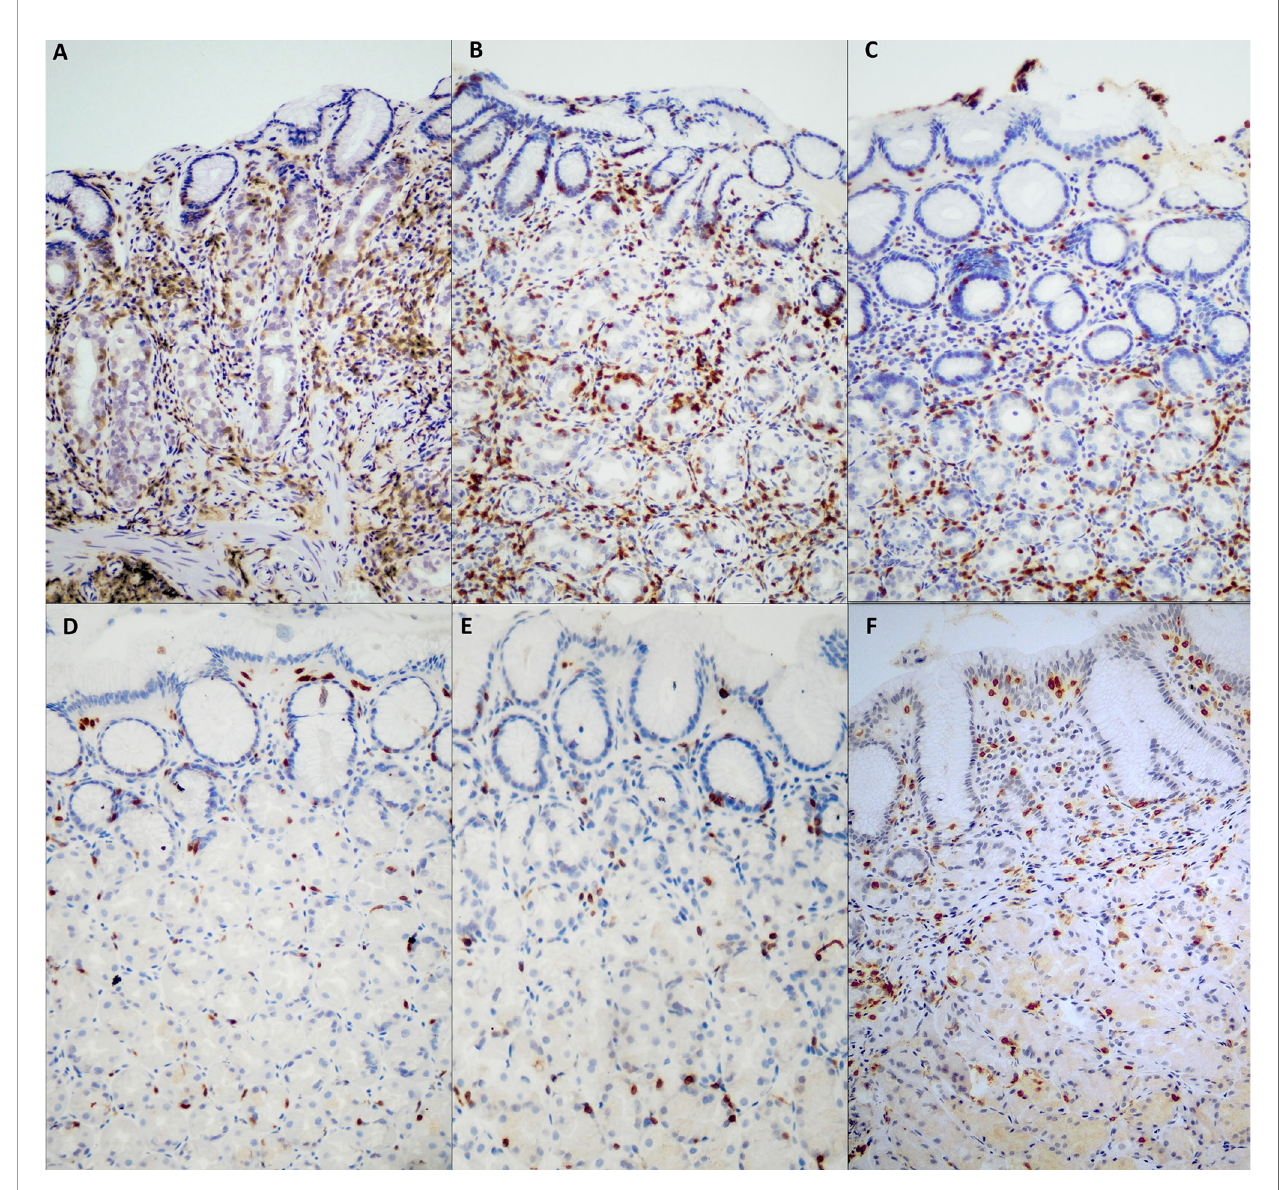
FIGURE 2 | CD3+ intraepithelial lymphocyte (IEL) distribution in samples of oxyntic mucosa (gastric body) from different groups. In severe AIG (A) , atrophic oxyntic mucosa is evident, together with a heavy CD3+ IEL in fi ltration in the deep portion of glands. In potential AIG at diagnosis (C) , a high number of CD3+ IEL is evident in deep oxyntic glands, resembling severe AIG (A) and mild AIG (B) , but in the absence of glandular atrophy. In Hashimoto ’ s thyroiditis gastric mucosa (E) , a low number of both super fi cial and deep intraepithelial CD3+ lymphocytes are evident, similarly to HC (D) . In (H) pylori infection (F) , CD3+ lymphocytes predominantly in fi ltrate the surface foveolar epithelium. [CD3 immunohistochemistry; original magni fi cation, 200x]. AIG, autoimmune gastritis; HC, healthy